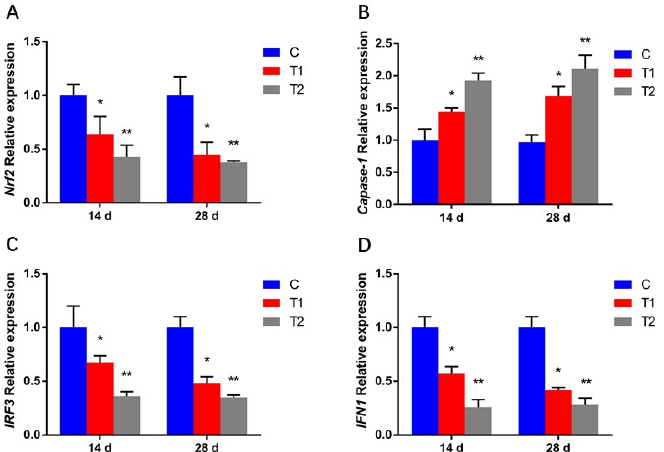
Figure 3. Effects of AFB1 on the mRNA levels of Nrf2( A ), Caspase-1( B ), IRF3( C ), and IFN1( D ) in gibel carp. C: control diet, T1: 50 µg/kg AFB1, T2: 100 µg/kg AFB1. Data represent the means ± SD (* p < 0.05, ** p < 0.01).